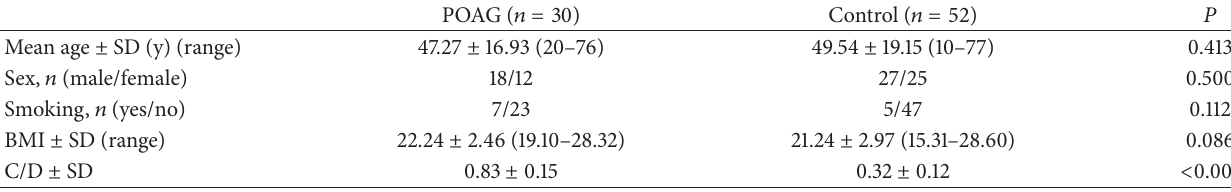
Table 1: Characteristics of the study eyes.